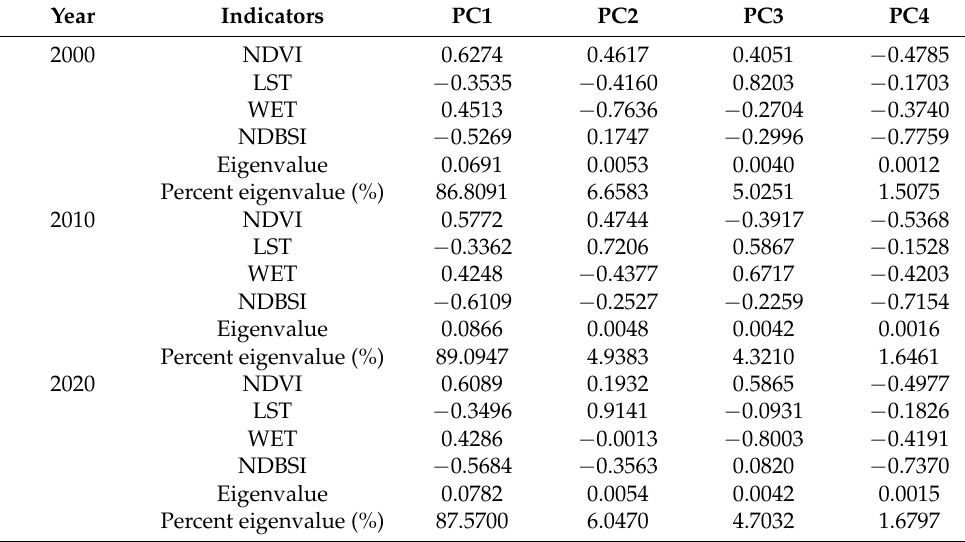
Table 3. Results of principal component (PC)